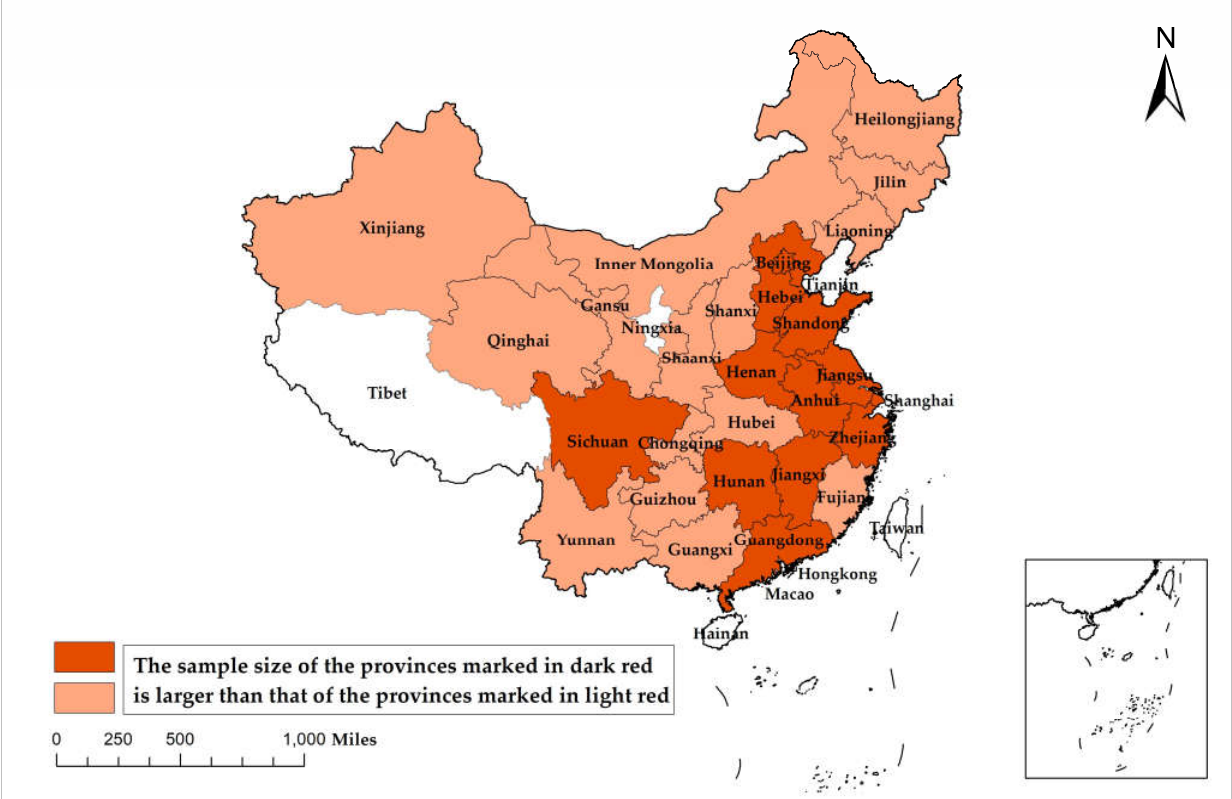
Figure 2. Sample distribution of the 2018 CHARLS. Source: CHARLS National Baseline Survey 2013 User Manual. Note: China now has 34 provinces (municipalities/autonomous regions/special administrative regions), and CHARLS 2018 covers 28 provinces, excluding Hong Kong, Macau, Taiwan, Hainan, Tibet, and Ningxia. Since CHARLS does not announce the specific sample size of each province, the sample size of different provinces can only be distinguished by the shade of